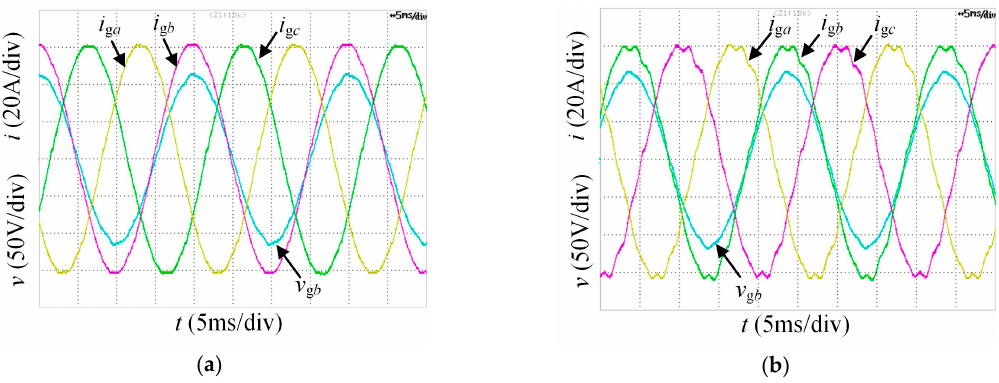
Figure 13. Steady-state full-load output current with different control strategies. ( a ) RC; and ( b ) PR.